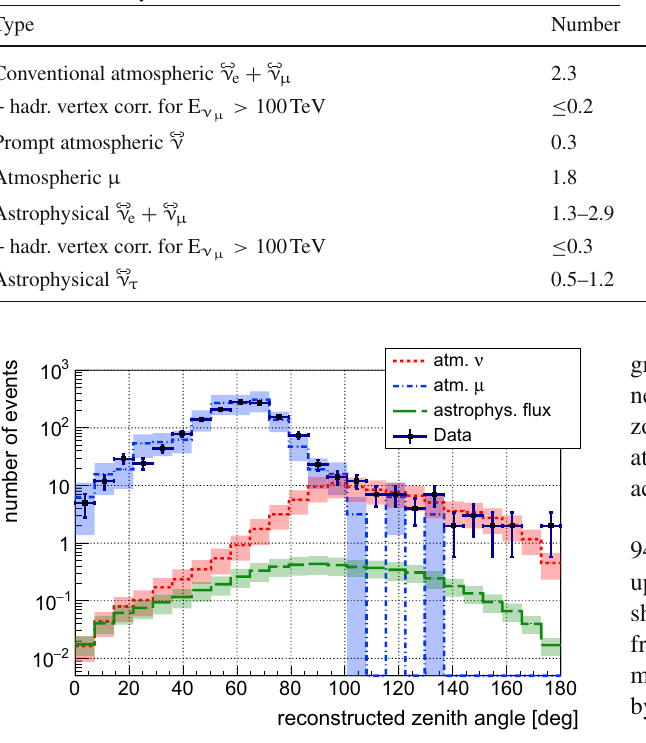
Fig. 3 Reconstructed zenith-angle distribution for 1247 days of data taking, with events selected as described in Sects. 4 and 5. Data points andtheirstatisticalerrorsaredepictedwith blackmarkers andcompared to simulated distributions of atmospheric muons ( blue ), atmospheric neutrinos ( red ) and the astrophysical flux reported in Ref. [6] ( green ). The coloured bands indicate the uncertainties on the simulated and measured flux